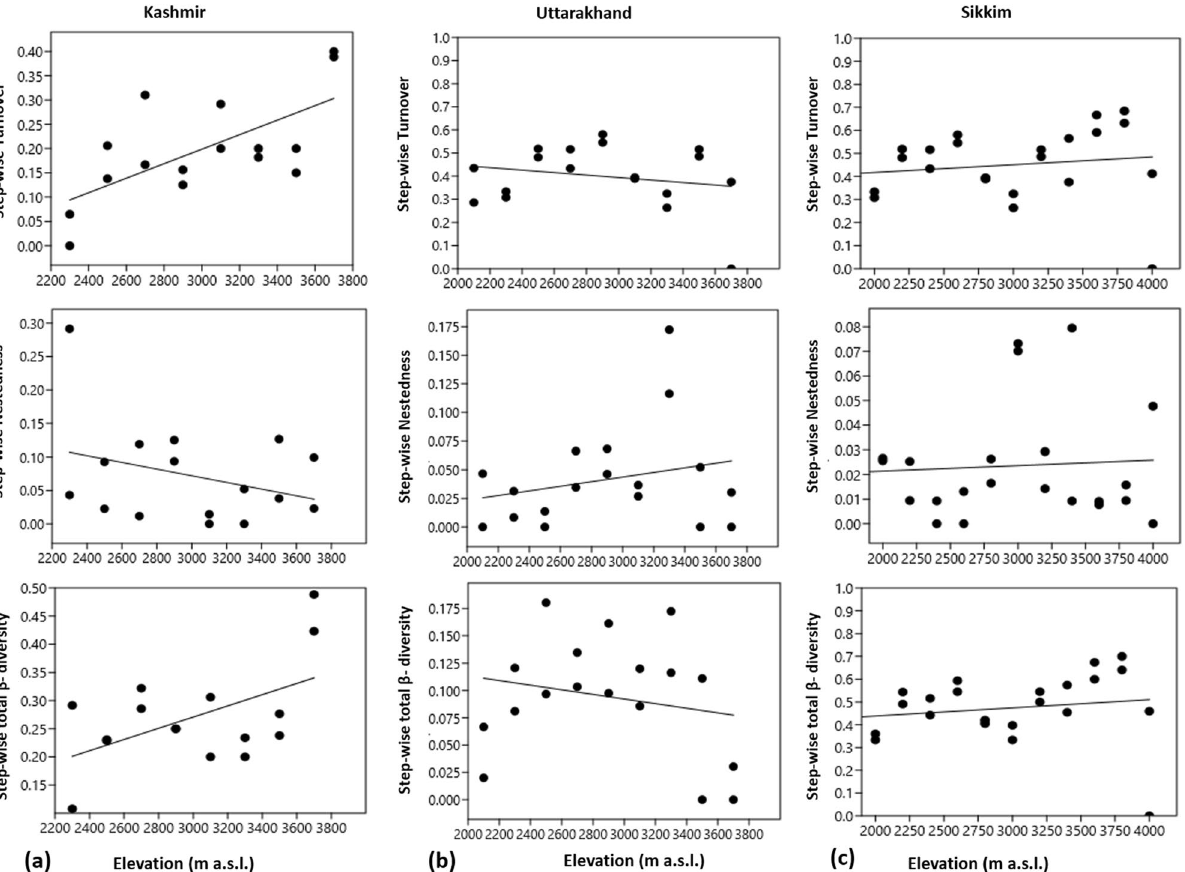
Figure 10. Stepwise turnover, nestedness and overall β-diversity: the effect of elevational distance on turnover, nestedness and overall β-diversity was tested with a linear mixed-effects model. The line indicates the response of turnover, nestedness and overall β-diversity to elevational distance and the points display their values of pair- wise the species level, but also at generic and family levels. However, the genus Cladonia and family Parmeliaceae, known for a wide tolerance range 49 , dominated across the studied transects (Figs. 5, 6). Parmeliaceae is the larg- est family world over representing 1/10th of lichen species 50 and its members grow on all types of substrates in a wide range of climatic conditions 51 . Though the species assemblages were taxonomically different, they were more or less functionally similar with the dominance of foliose and corticolous lichens (Table 2). We argue that this may be due to the large share of forest area in each of the transects which provides broadly similar habitats for the functionally similar lichen species to grow. Species richness patterns along the elevation gradient were not consistent across different growth forms and habitat categories. From north-western Kashmir to eastern Sikkim, spline.plots revealed the most common hump-shaped distribution pattern in overall macrolichen rich- ness (Fig. 8a) which is consistent with other studies across Himalaya for similar taxa 49,52,53 and for other taxa such as vascular plants 54 , seed plants 55 , ferns 56 , bryophytes 57 . In Uttarakhand transect, however, a low plateau type pattern was reported that has often been reported in birds, reptiles and plants 58 . Among the growth forms, foliose lichens and among substrate categories, corticolous lichens also revealed the common hump-shaped elevation pattern in Kashmir and Sikkim but a low plateau pattern in Uttarakhand transect (Fig. 8b,c). The other growth forms and substrate categories of lichens that showed hump-shaped pattern with elevation include fruticose, squamulose and terricolous in Uttarakhand and Sikkim transects, respectively. A hump-shaped pat- tern in terricolous lichens along elevation gradient has been earlier reported in Garhwal Himalaya as well 53 . The hump-shaped distribution of foliose lichens may be due to their ability to utilize the light even at shady places of thick forests and on low canopy twigs 59 , and for fruticose lichens, mid-elevational pattern could be because of their tolerance to severe environmental limits, acidic soils and effect of grazing which is quite common at mid altitudes in the Himalaya 49,60 . Nonetheless, for corticolous lichens, this may be attributed to an increase in forest cover from low to mid-elevations, thereby offering suitable habitats for them and less suitable habitats for saxicolous lichens which show more or less increasing richness above the treeline ecotone due to an increase in rocky substrates 54,61 . Hump shaped pattern in the case of terricolous lichens may be due to a decrease in overall soil cover at upper elevations 49 . While inverse hump-shaped patterns were observed for crustose and saxicolous forms in Kashmir, some growth forms and substrate categories did not show any significant relationship with elevation (Fig. 8). The inconsistency in species richness patterns among various growth forms and substrate